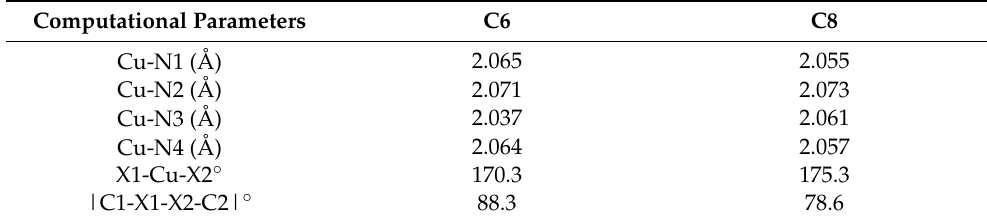
Table 4. Computational parameters of C6 (calculated with Gaussian).